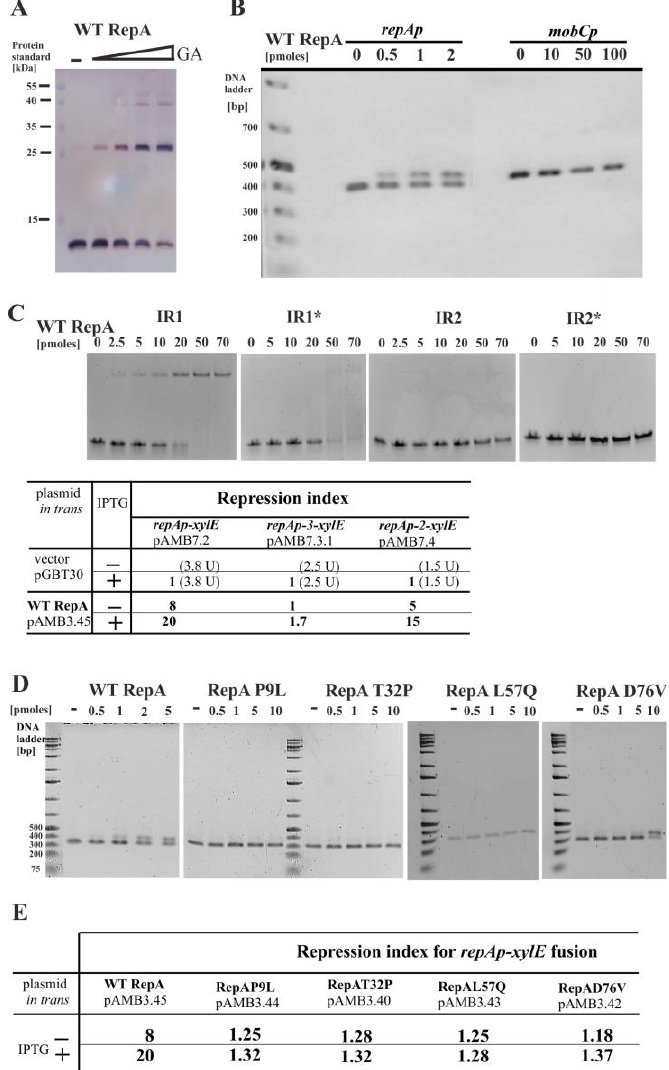
Figure 6. Properties of RepA ( A ) Dimerization in vitro. The His 6 -RepA was overproduced in the cultures of BL21(pAMB11.47) and purified by the affinity chromatography. The purified His 6 -RepA protein (0.025 mg mL − 1 ) was incubated with increased concentration (0.001, 0.005, 0.01, and 0.05%) of the cross-linker glutaraldehyde (GA) and complexes resolved by PAGE on 16.5% denaturing polyacrylamide gel. The complexes were transferred to nitrocellulose membrane and visualized by western hybridization with anti-His tag antibodies. ( B ) Specificity of RepA DNA binding activity. The His 6 -RepA protein was incubated with 30 ng of two PCR products corresponding to repAp (primers #1 and #2) or mobCp (#43 and #44). The complexes were separated at 0.8% agarose gel in 0.5xTBE buffer, ethidium bromide stained, and photographed. ( C ) Identification of the RepA operator. Upper panel: His 6 -RepA protein was incubated with 150 ng of ds oligonucleotides corresponding to the inverted repeats detected in the repAp region, IR1 (#45/#46), and IR2 (#47/#48). In parallel, the same length fragments with scrambled inverted repeats were used, IR1* (#49/#50) and IR2* (#51/#52). The products of reactions were separated by PAGE on 10% acrylamide gel in the 0.5xTBE buffer, ethidium bromide stained, and photographed. Bottom panel: The in vivo effect of IR1* and IR2* substitutions in the repAp-3 - xylE and repAp-2-xylE transcriptional fusions, respectively. The expression vector pGBT30 and its derivative pAMB3.45 with repA ORF cloned under tacp were used to transform E.